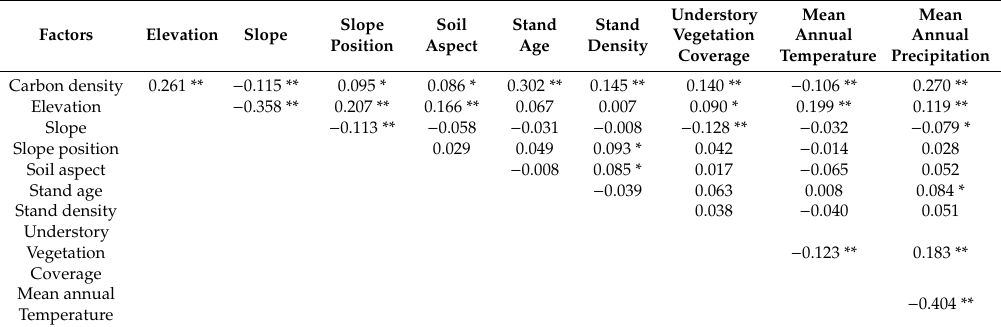
Understory Slope Soil Stand Stand Vegetation Position Aspect Age Density Coverage Temperature Precipitation